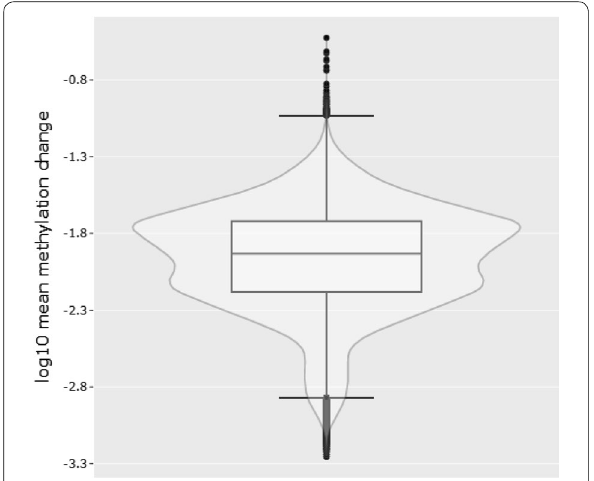
Fig. 1 Boxplot depicting the log10 mean change in methylation (β) between baseline and 1‑year follow‑up